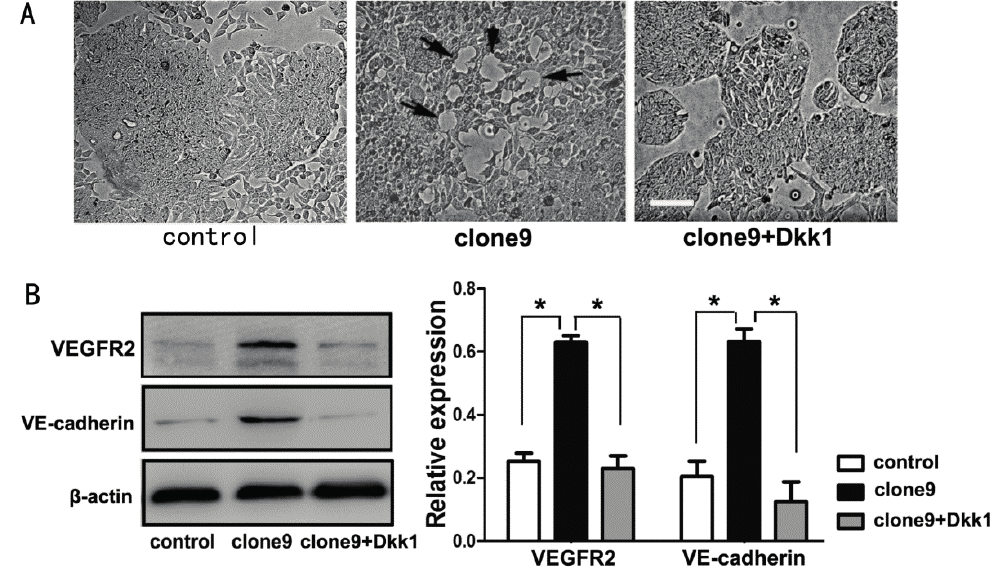
Figure 5. Dkk1 reversed the VM-forming ability in Wnt3a-overexpressing HT29 cells. ( A ) Dkk1 inhibited the in vitro tube-like structure formation (black arrows) of Wnt3a-overexpressing HT29 cells (clone9). Scale bar: 100 μ m; ( B ) Dkk1 restored the expressions of VEGFR2 and VE-cadherin in clone9 cells ( left ). Relative amount of protein expressions of VEGFR2 and VE-cadherin compared with β -actin ( right ) ( * p <